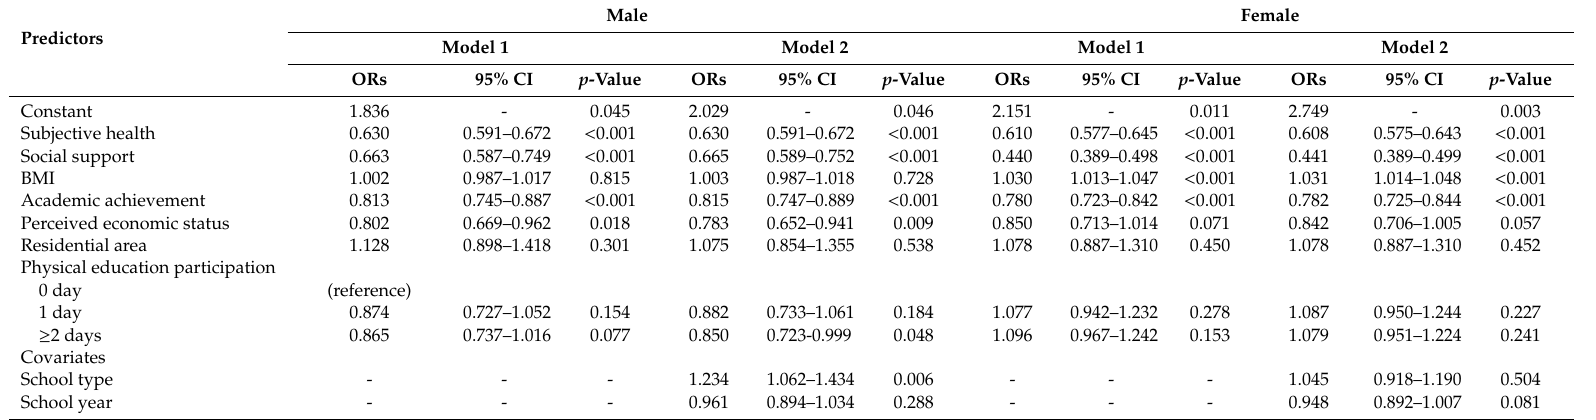
Table 2. Predictors of suicidal ideation (N = 28,451).